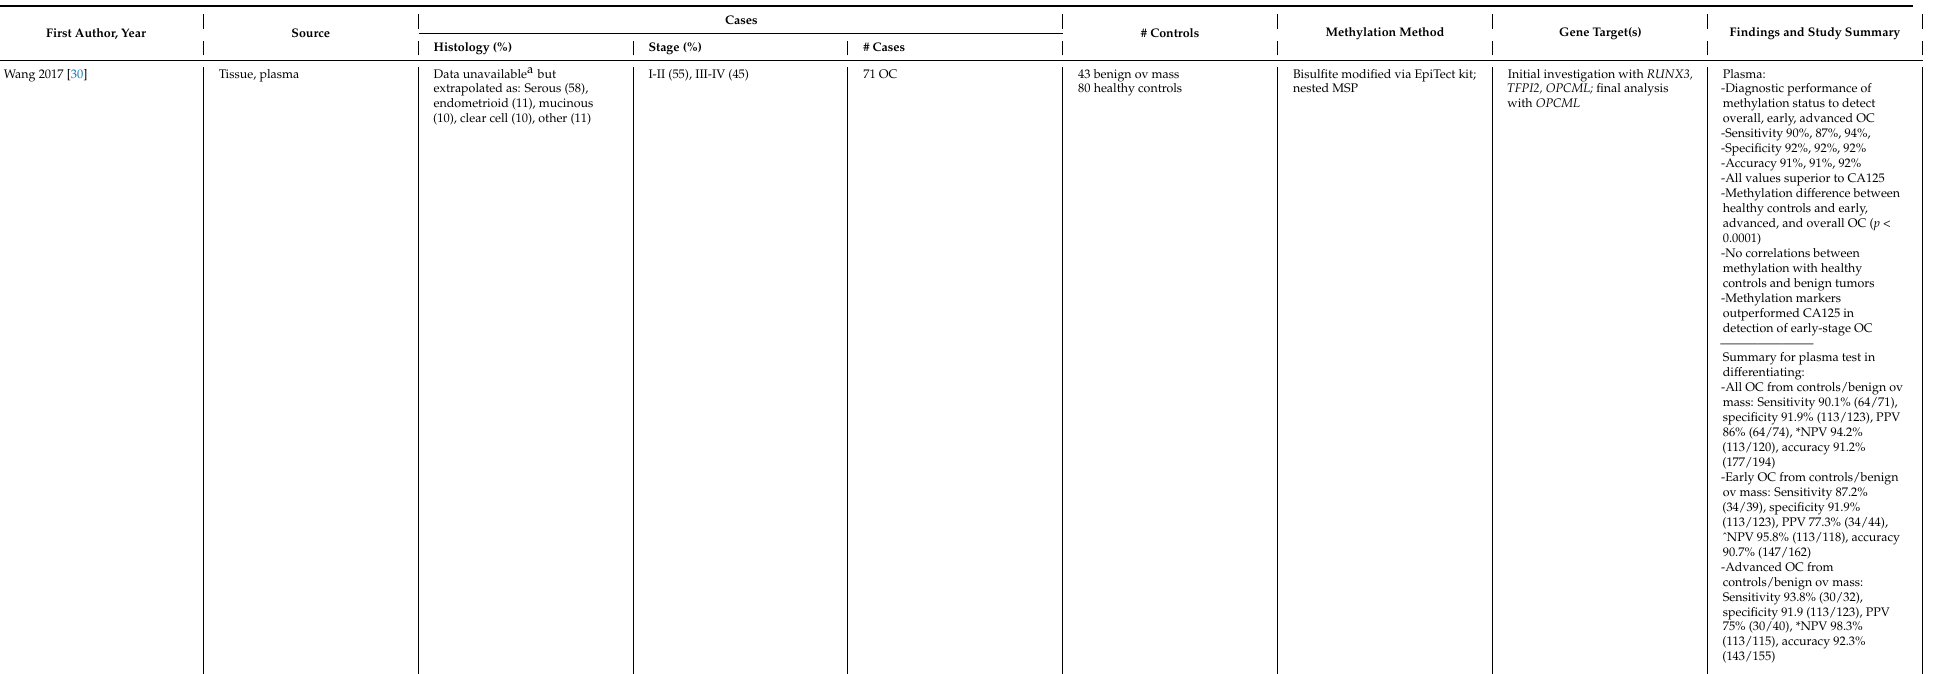
———————– Summaryforplasmatestin